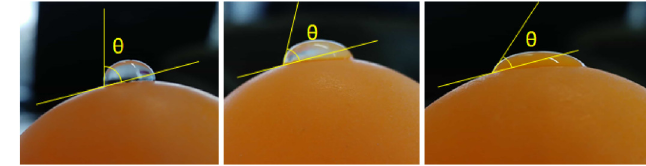
Fig. 3. Measurement of the contact angle using a water drop on ping-pong balls with different wetting properties. From left to right, θ = 79 . 5 ◦ , 65.5 ◦ and 48.1 ◦